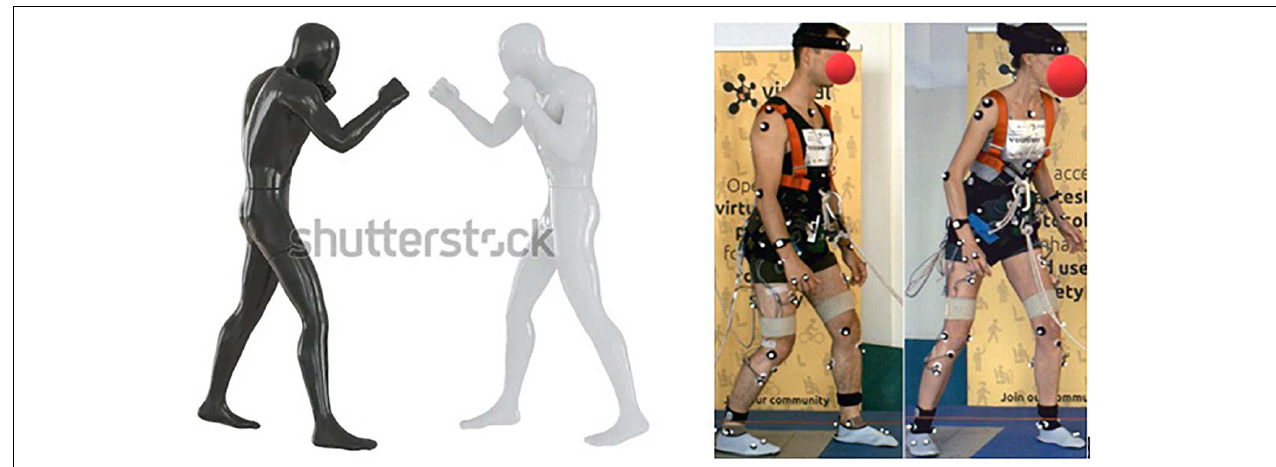
FIGURE 6 | Fighting stance in martial arts ( left ) and Volunteers 12 and 16 displaying their fighting stance ( right ). Left picture from (attached link): Two Male Mannequins Black White Fighting Stock Illustration 1877892802 (shutterstock.com)–Accessed 3 Feb 2021.